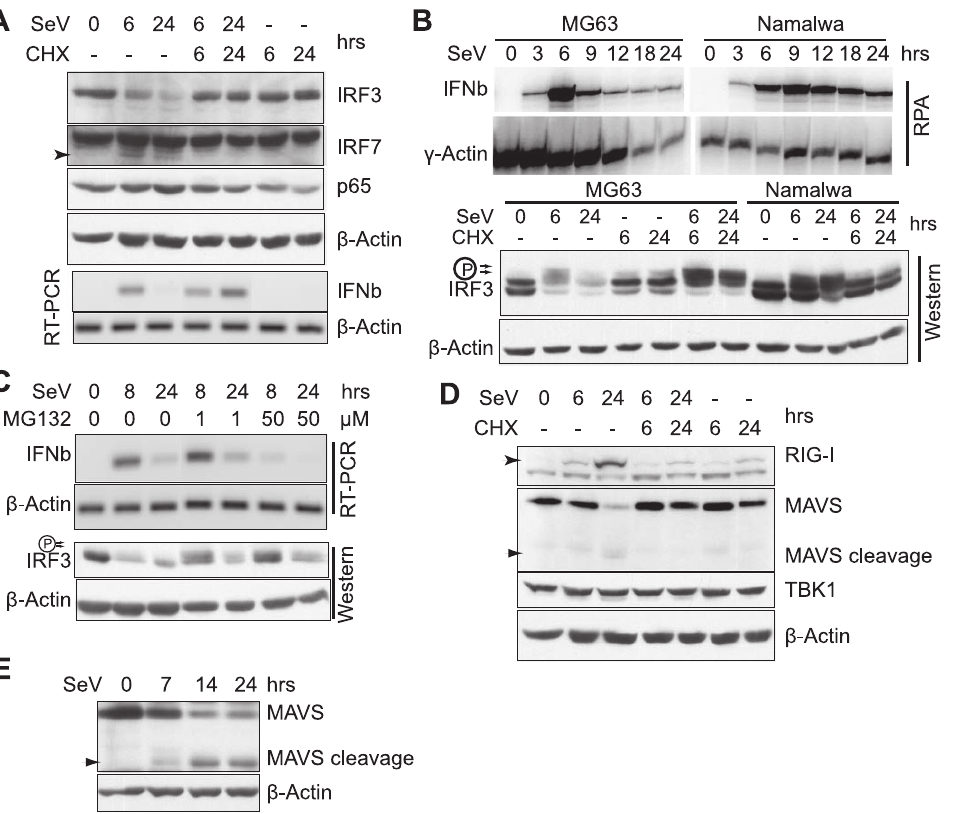
Figure 1. The degradation of IRF3 correlates with the turn-off of IFN b expression. A . Virus-induced IRF3 degradation is blocked by CHX treatment. MEFs were treated with SeV and/or CHX for the indicated times. Half of the samples were lysed for total protein extracts and subjected to western blot analysis, probing for IRF3, IRF7, p65 and b -Actin. RNA was extracted from the other half of the sample. cDNAs were prepared and the expression of IFN b and b -Actin monitored by RT-PCR. B . CHX blocks virus-induced degradation of IRF3 in human cells. Human MG63 or Namalwa cells were treated as in A, total protein was prepared and analyzed for the expression of IRF3 and b -Actin. RNase protection assays (RPA) were conducted to monitor the expression of IFN b and c -Actin mRNA (top panel). C . The proteosome inhibitor MG132 only partially inhibits the virus-induced degradation of IRF3. MEFs were infected with SeV in the presence or absence of 1 m M or 50 m M of MG132 for the indicated times, cells were harvested for analysis of IRF3 and b -Actin protein expression or IFN b and b -Actin mRNA levels. D . The MAVS protein is cleaved and degraded in SeV infected MEFs. MEFs were treated the same as in A, and the level of RIG-I, MAVS, and TBK1 proteins monitored using the appropriate antibodies. E . Cleavage and degradation of MAVS revealed by another antibody. MEFs infected by SeV were lysed at different time points, and subjected to western blot analysis with another anti-mouse MAVS antibody.